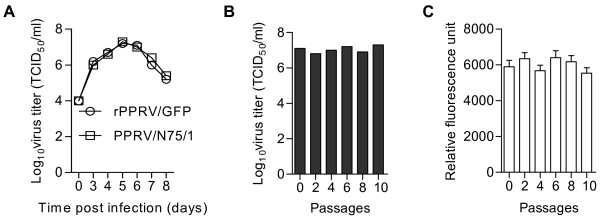
Growth and stability of rPPRV/GFP in vitro. (A) Vero cells were infected with PPRV/N75/1 or rPPRV/GFP, and the amount of virus in the cultures was measured at various times from 0 to 8 d post-infection. (B) rPPRV/GFP was passaged in Vero cells every 6–7 d, and culture medium and cells of each passage was freeze-thawed twice and used for virus titration (B) and to analyze GFP expression by quantitating relative fluorescence (C). Data are expressed as the mean ± standard deviation (SD).